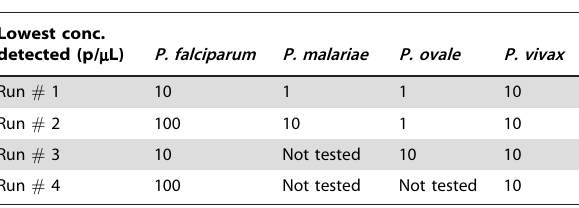
Table 1. Detection limits of the RealAmp method tested using 10-fold serial dilutions of P. falciparum P. vivax, P. ovale and P. malariae